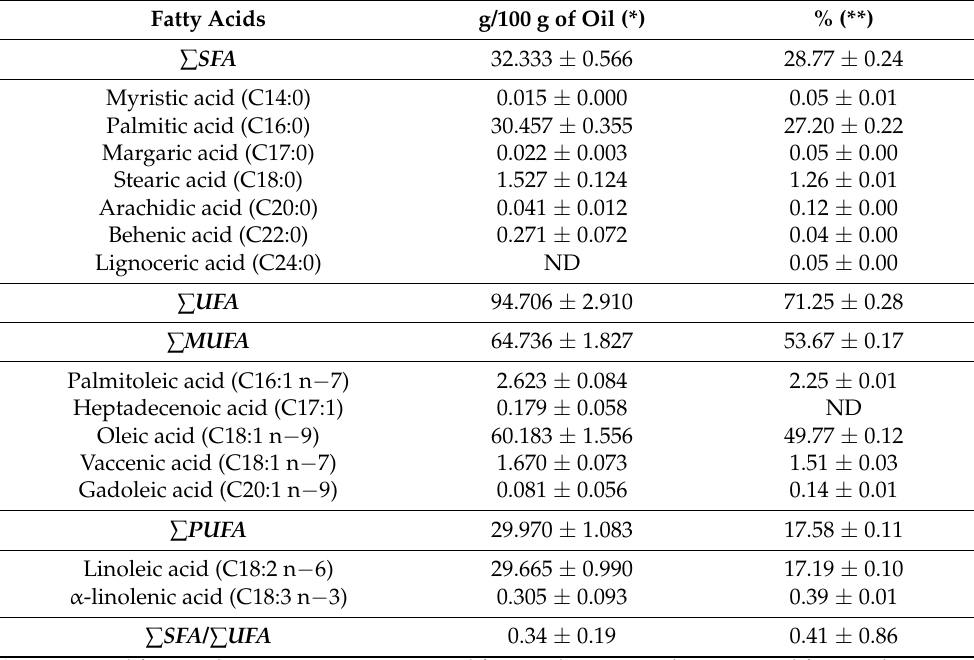
Table 3. Pistacia lentiscus seed oil fatty acids profile (g/100 g of oil; % of total fatty acids).